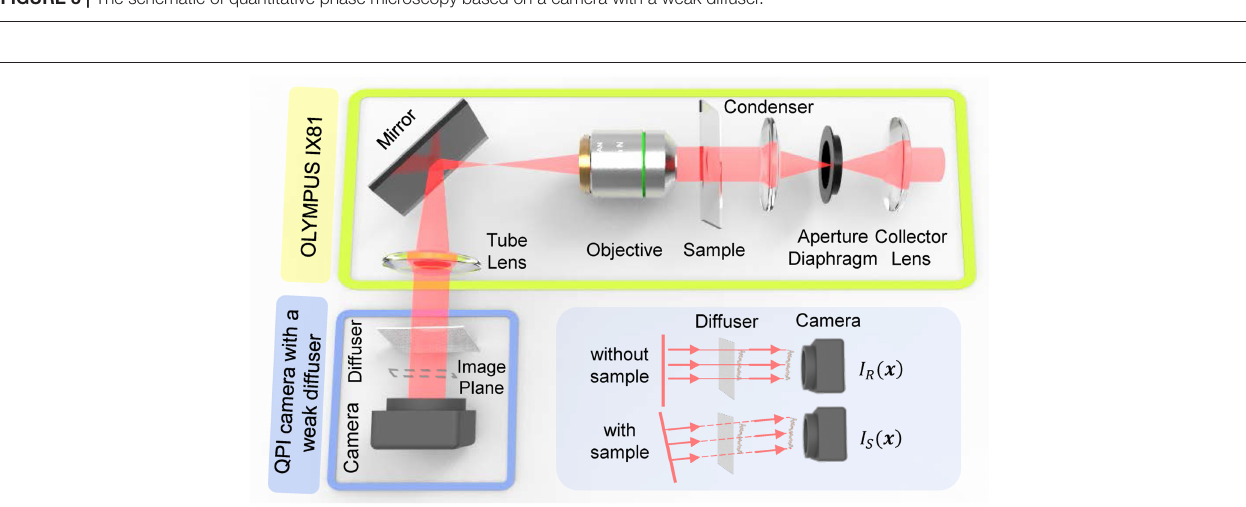
FIGURE 3 | The schematic of quantitative phase microscopy based on a camera with a weak diffuser.